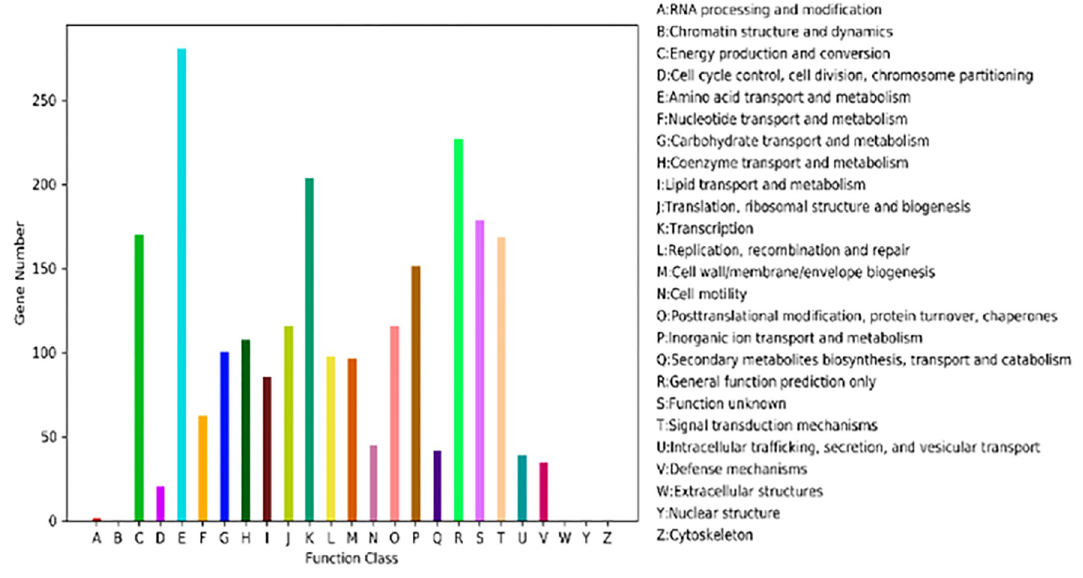
Fig 2. COG enrichment analysis of